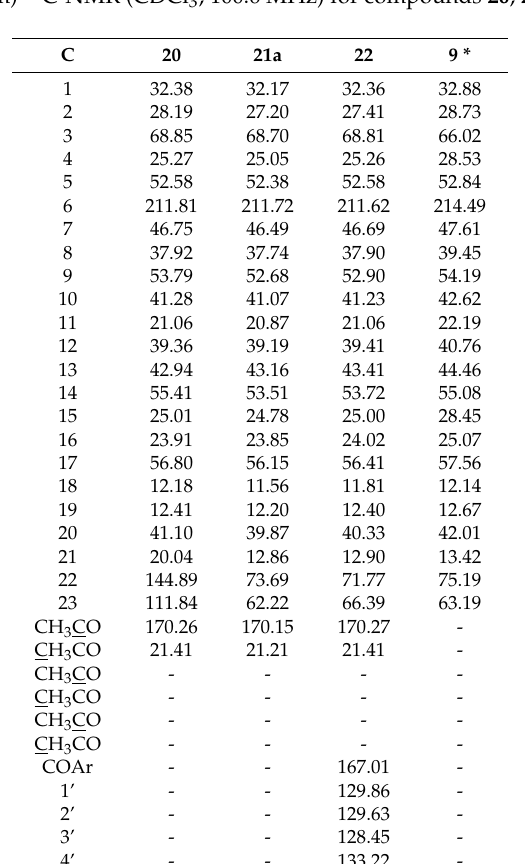
Table 1. δ (ppm) 13 C-NMR (CDCl 3 , 100.6 MHz) for compounds 20 , 21a , 22 , and 9